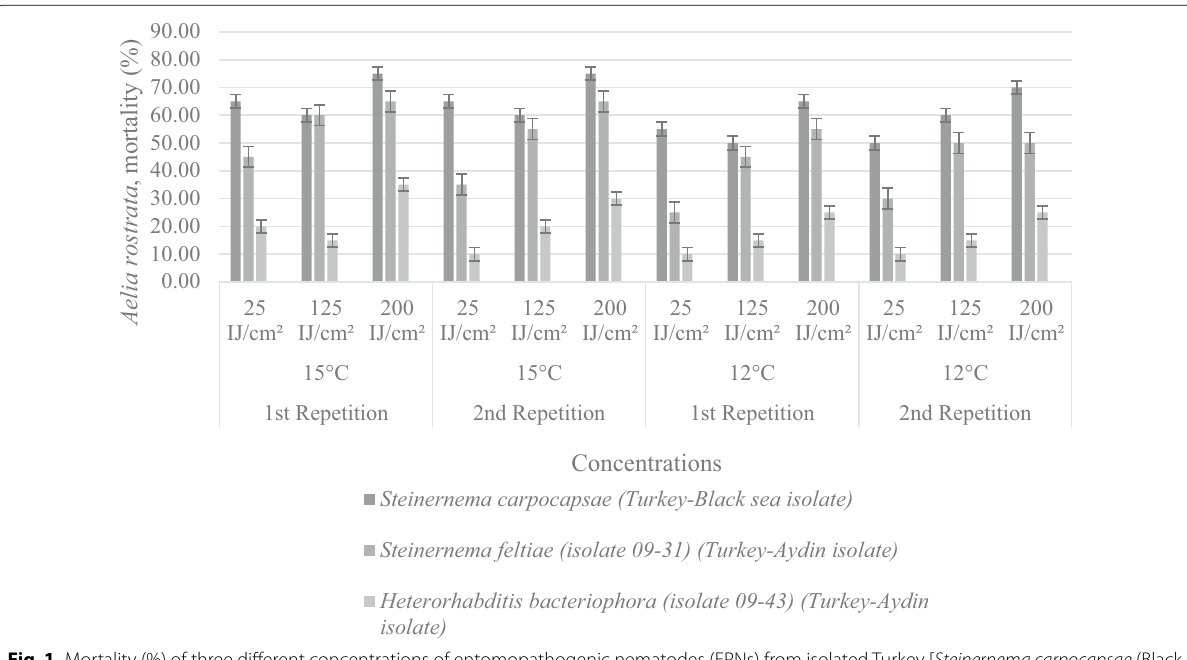
Fig. 1 Mortality (%) of three different concentrations of entomopathogenic nematodes (EPNs) from isolated Turkey [ Steinernema carpocapsae (Black sea isolate) , S. feltiae (isolate 09-31) (Aydin isolate), and Heterorhabditis bacteriophora (isolate 09-43) (Aydin isolate)] on wheat stink bug, Aelia rostrata adults at 15 °C and 12 °C (first and second repetitions) ( P <